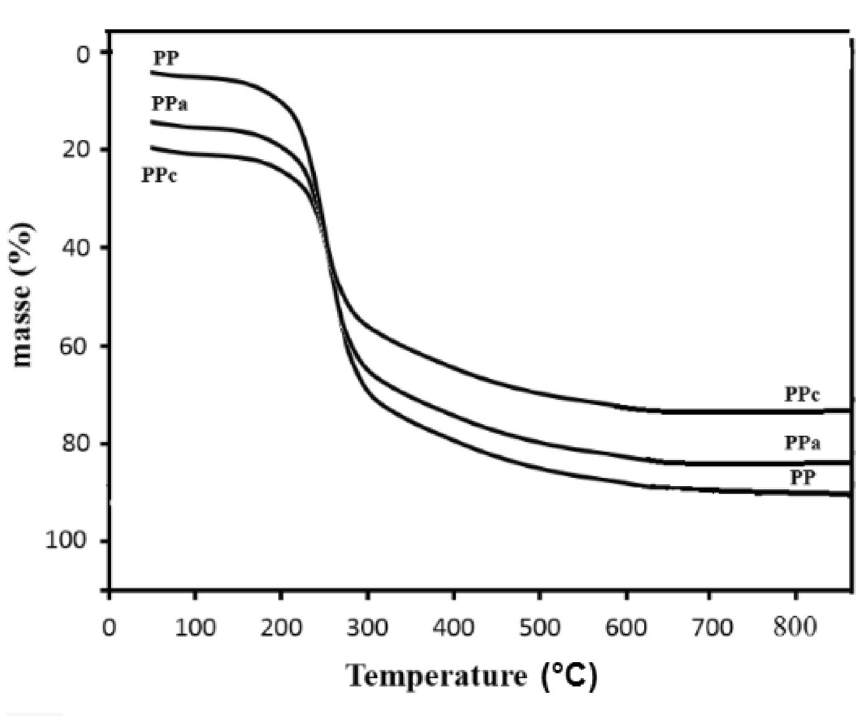
Figure 4. Thermogravimetric (TG) curve of the native, activated material and calcined material.